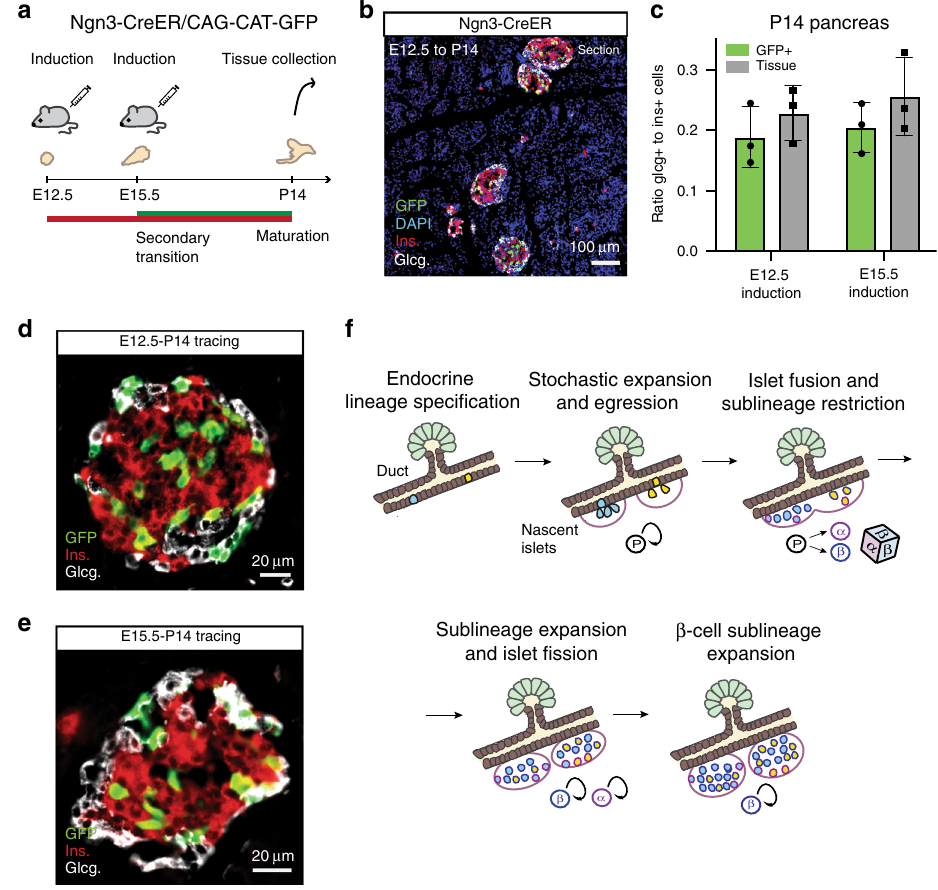
Fig. 5 Lineage tracing using Ngn3 promoter con fi rms contemporary speci fi cation of α and β -cell lineages. a Experimental schedule for Ngn3-CreER lineage tracing at non-clonal levels of induction. b Wide- fi eld section of tissue showing typical labelling ef fi ciency based on 3 experiments (and >10 images) from E12.5 to P14 tracing with labelled cells marked by GFP. c Quanti fi cation of the ratio of glucagon + to insulin + cells on thin sections from islets as a whole and from labelled (GFP + ) cells from E12.5 to P14 and E15.5 to P14 tracings ( n = 83 and n = 81 islets, respectively, from N = 3 mice). Error bars show mean ± SD. Representative images of GFP + cells within islets based on 3 experiments (and >25 images each) traced d from E12.5 to P14 and e from E15.5 to P14. Insulin is red and glucagon is white for ( b , d , e ). f Summary of the key events in islet formation based on current fi ndings: endocrine progenitor